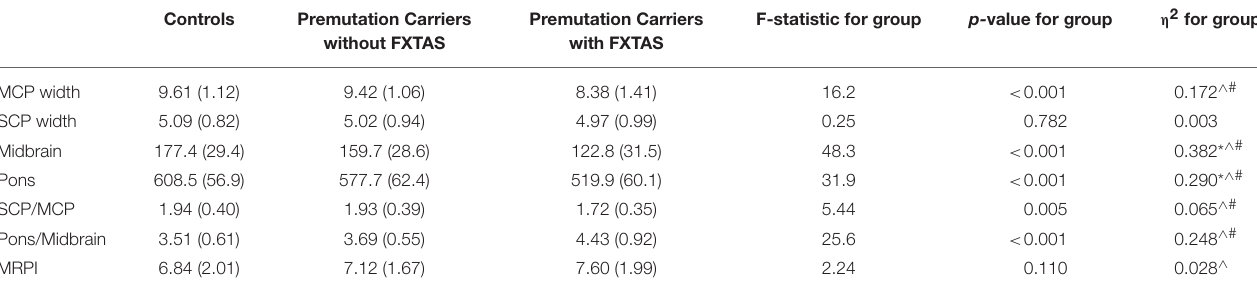
TABLE 2 | Summarized statistics (mean and standard deviations) and ANCOVA/ANOVA statistics for the main effect of group when comparing controls and premutation carriers with and without FXTAS. Controls Premutation Carriers Premutation Carriers F-statistic for group p- value for group η 2 for without FXTAS with FXTAS